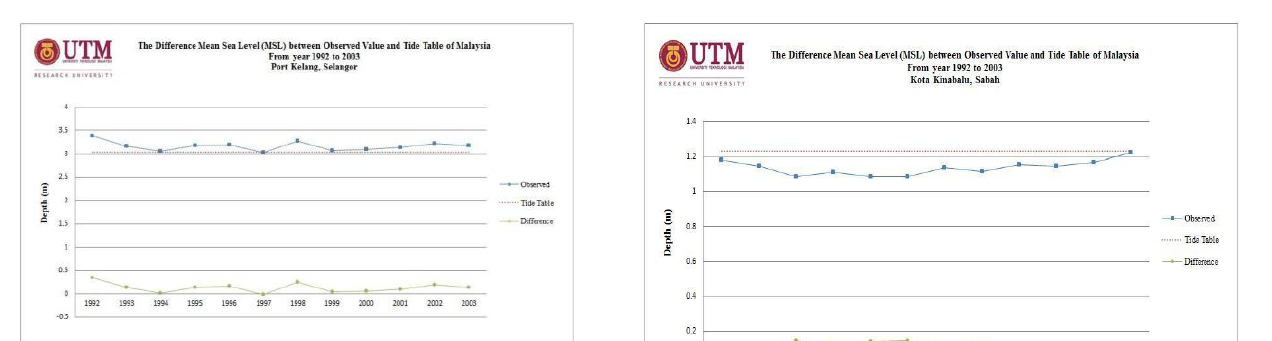
Figure 19. Graph of Difference Mean Sea Level (MSL) between Observed Value and Tide Table of Malaysia at Port Kelang, Selangor.